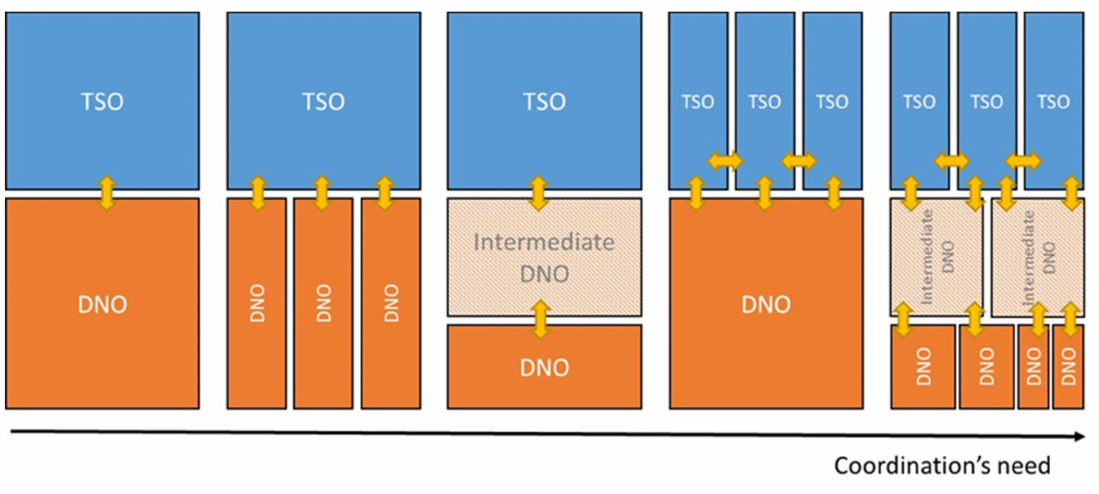
Figure 2. Types of possible organizational structures and need for